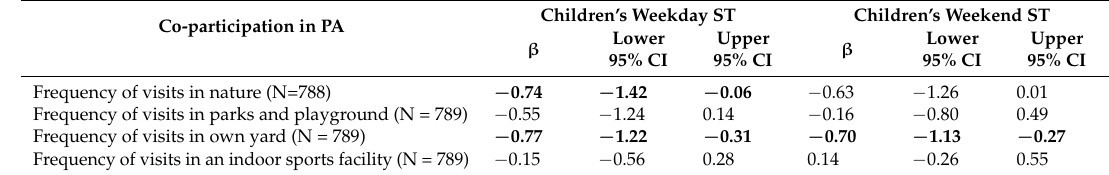
Table 4. The associations between co-participation in physical activity and children’s sedentary time (ST) on weekdays (N = 789) or on weekends (N = 786), adjusted for gender of parental questionnaire respondent, child’s gender and age, measurement season, and parental educational background * . Co-participation in PA